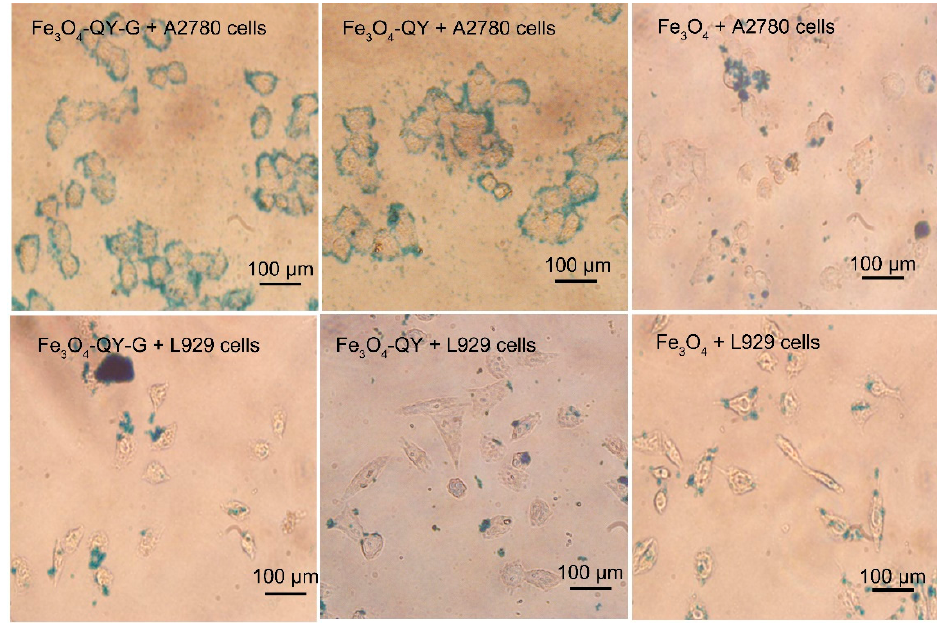
Figure 8. Prussian blue staining images of A2780 and L929 cells incubated with Fe 3 O 4 -QY-G, Fe 3 O 4 -QY, or Fe 3 O 4 nanoparticles for 4 h.